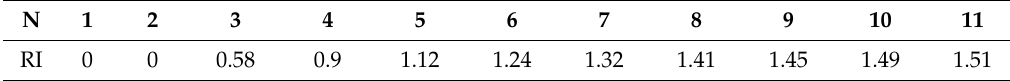
Table 4. Random index (RI) values used to compute the consistency ratio (CR) [41].